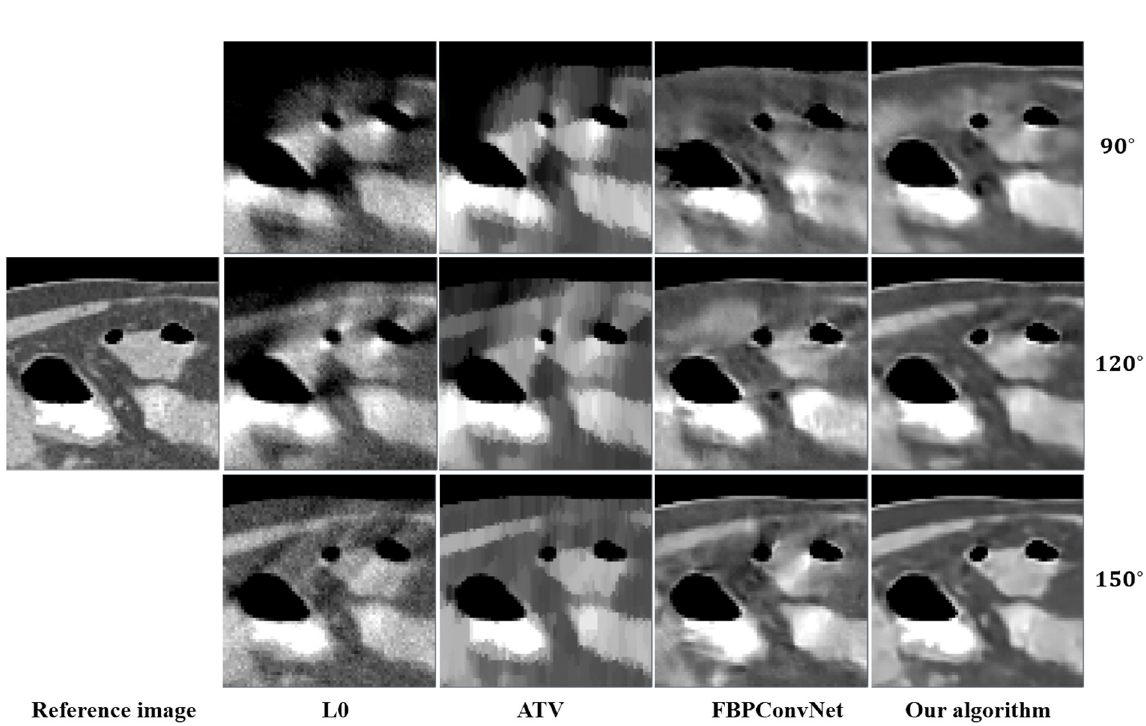
Fig 12. The zoom-in view of the ROIs for the Fig 10. The image on the first column is the ROI of the reference image. The subsequent columns are the ROIs of the reconstructed image for L0 method, ATV method, FBPConvNet method and our algorithm. https://doi.org/10.1371/journal.pone.0226963.g012 PLOS ONE | https://doi.org/10.1371/journal.pone.0226963 January 6,